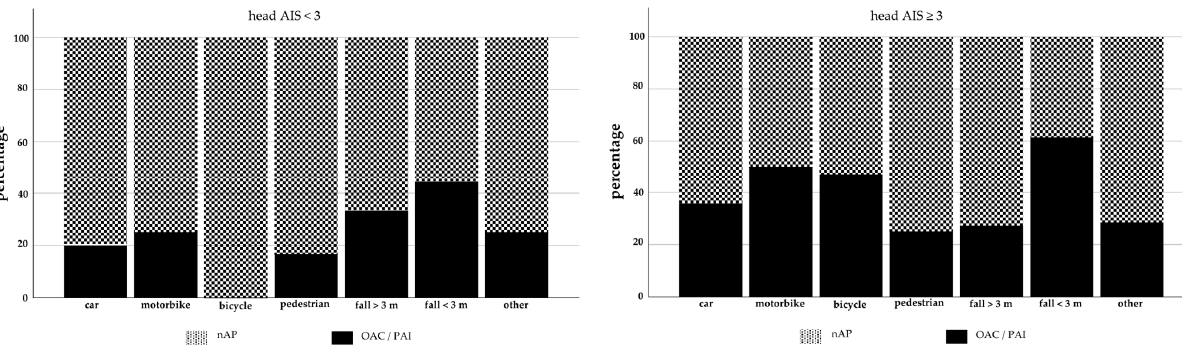
Figure 3. Percentage of head injuries (AIS < 3 vs. AIS ≥ 3) related to trauma mechanism.